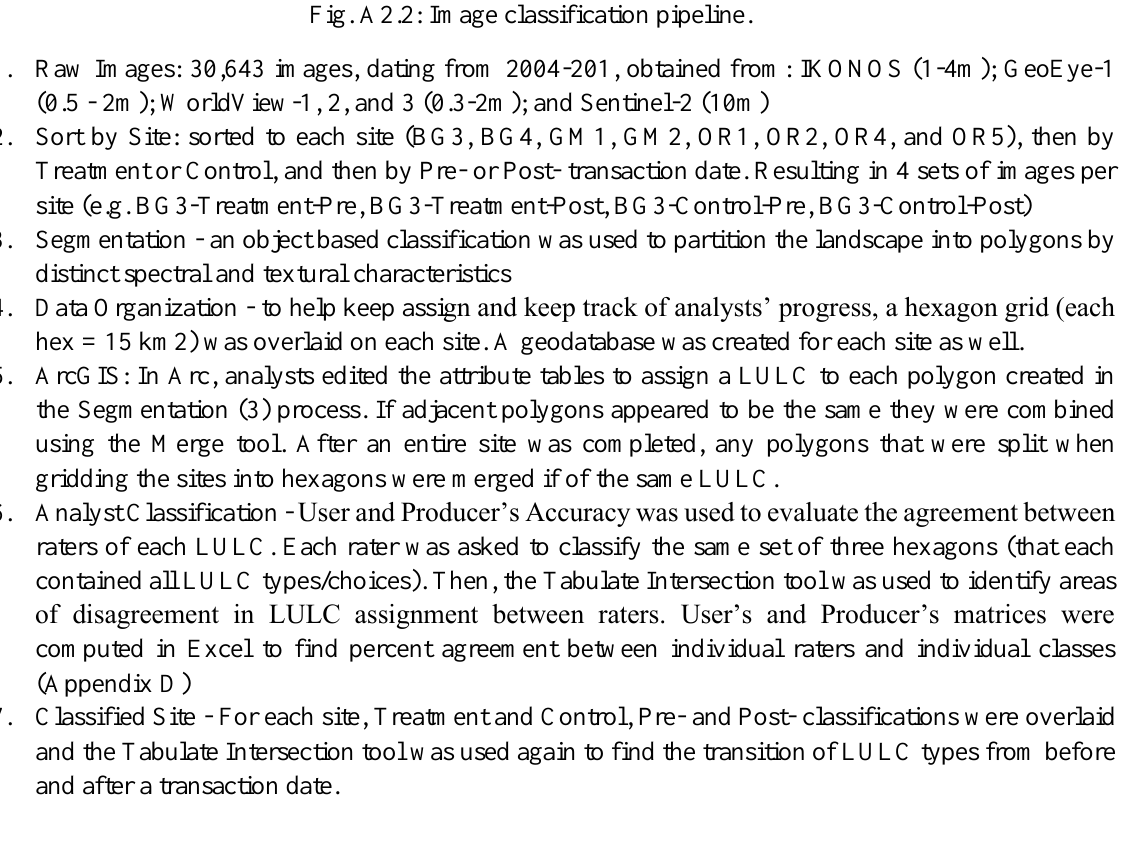
Fig. A2.2: Image classification